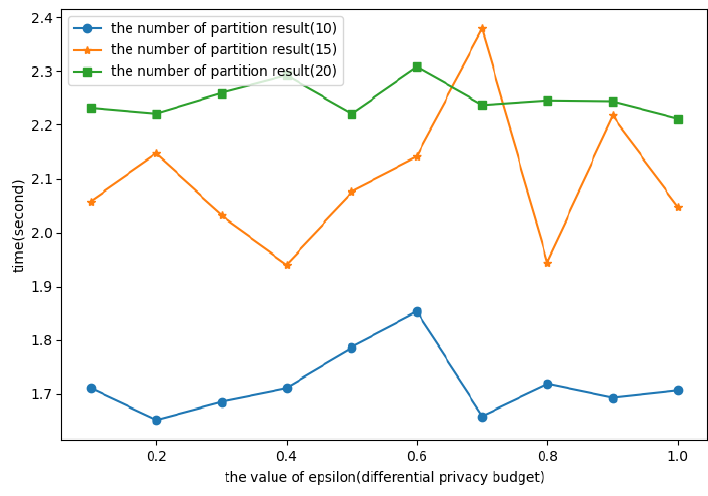
Figure 14. Time cost with different epsilon (Geolife dataset).